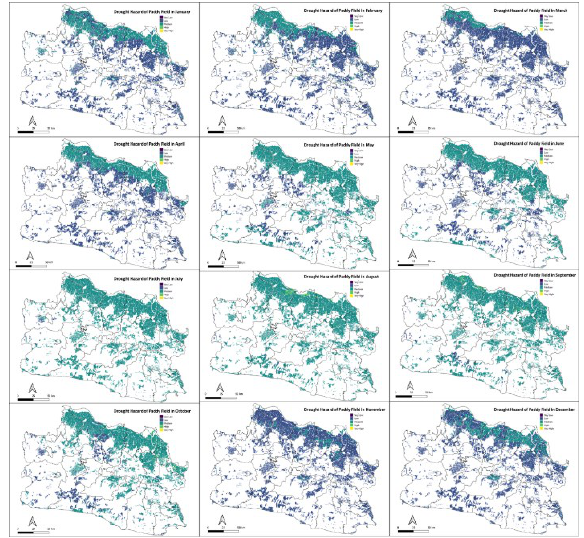
Figure 6 . Drought hazard model in the rice fields every month in 2021